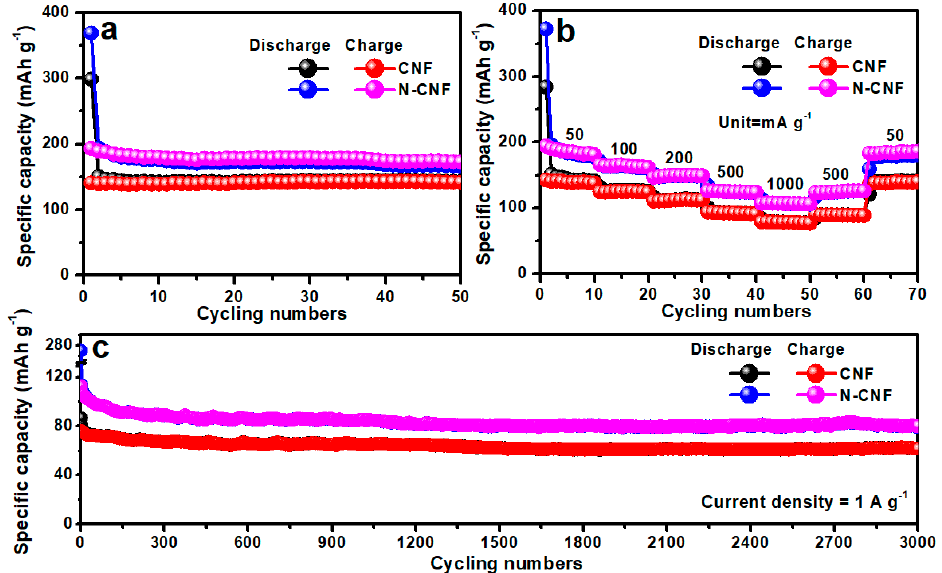
Figure 4. ( a ) Cycle performance, ( b ) rate performance and ( c ) long-term cycle performance of CNF and N-CNF for K-ion storage.